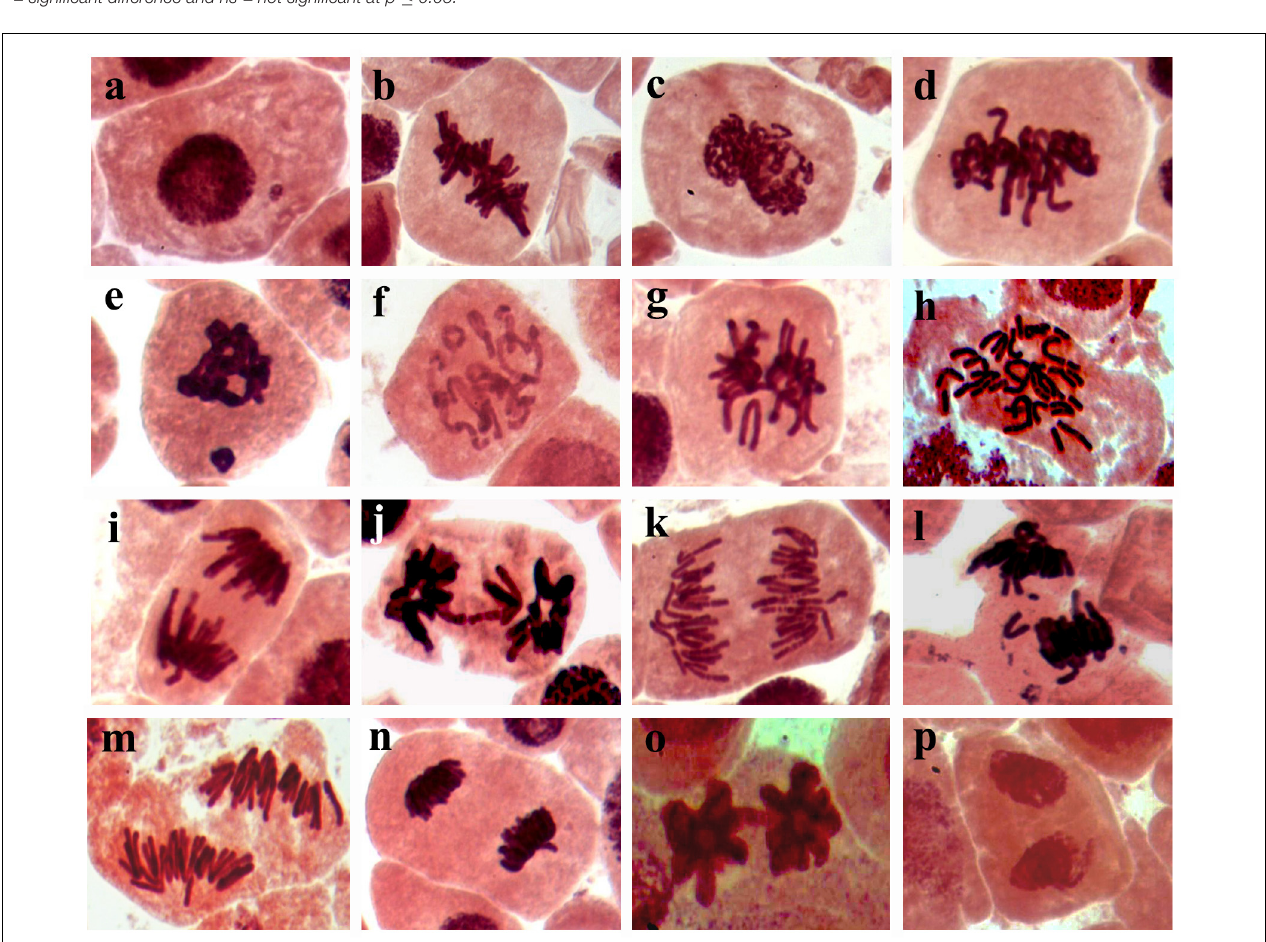
FIGURE 6 | Light micrographs (1,000x) showing mitotic abnormalities in Allium cepa root tips in response to treating with SiNPs at 150 ppm for 24 h, where (a) micronucleus at interphase, (b) oblique at metaphase, (c) stickiness at metaphase, (d) disturbance at metaphase, (e) micronucleus at metaphase, (f) ring at metaphase, (g) non-congressing at metaphase, (h) polyploidy at anaphase, (i) late separation at anaphase, (j) bridge at metaphase, (k) disturbance at anaphase, (l) laggard at anaphase, (m) diagonal at anaphase, (n) disturbance at telophase, (O) bridge at telophase, and (p) diagonal at